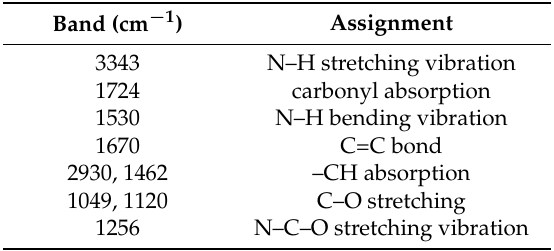
Figure 4. Infrared spectroscopy (FT-IR) of WUVCW with different CaCO 3 and talcum content (samples 11, 5, 23 and 6 in Table 1). Table 7. The assignment of band.